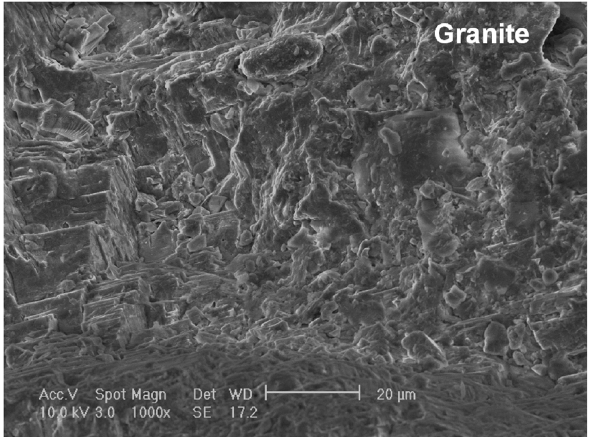
Fig. 5 SEM image of crushed granitic granules.